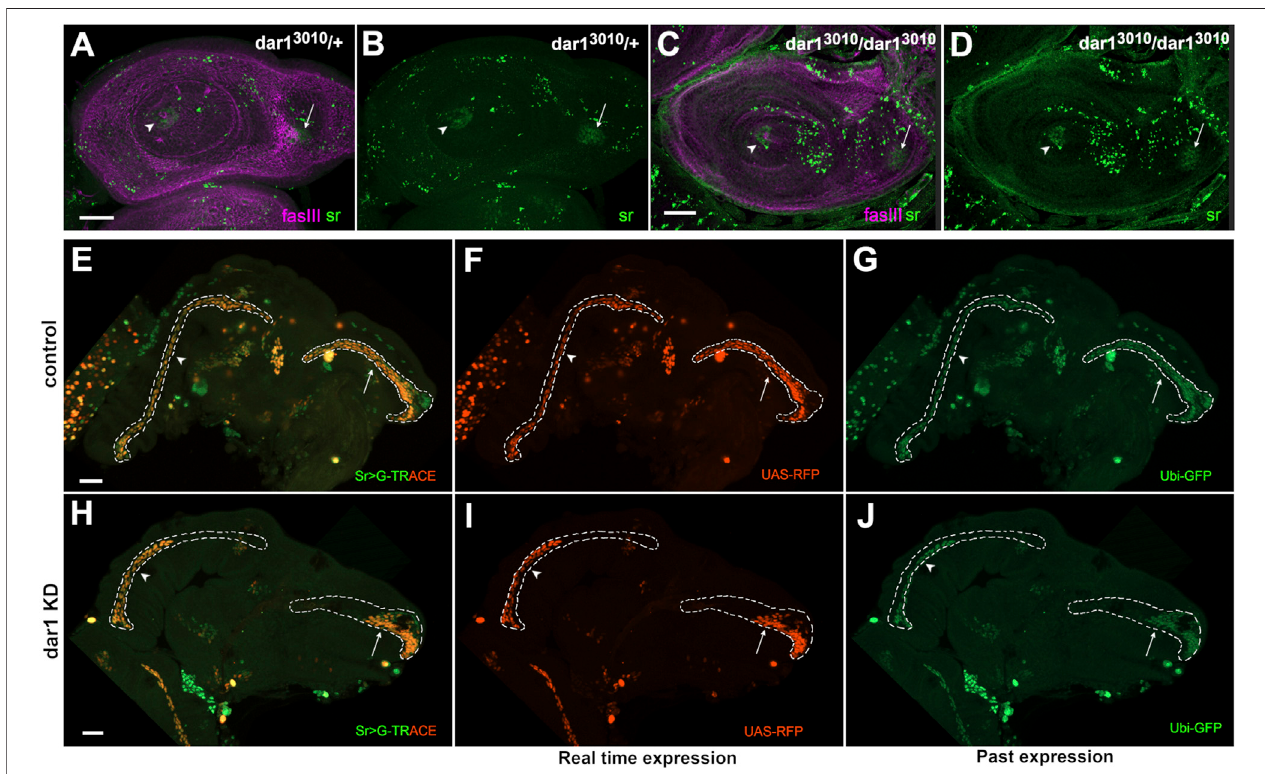
FIGURE 7 | Dar1 is not required to initiate or maintain stripe expression (A – D) Confocal sections of L3 leg discs immunostained with anti-sr (green) and anti-fasIII (magenta) (A – B) In dar1 3010/+ heterozygousleg discs, stripe expression revealstendon cell precursors intarsal segments(arrowhead)andin dorsal femur(arrow) (C – D) In the leg disc of rare dar1 3010/3010 homozygous mutant escapers, stripe expression is still observed in tarsal segments (arrowhead) and dorsal femur (arrow) (total number of analysed discs, control dar1 3010/+ (cid:2) 15, dar1 3010/3010 n (cid:2) 12) (E – J) G-TRACE in sr-gal4,dar1 3010/+ (E – G) and sr-gal4,dar1 3010/+ > UAS-dar1RNAi (H – J) leg discs at 5 h APF. RFP (red) staining shows current sr-gal4 expression (F, I) and GFP (green) reveals past expression (G, J) (E,H) merged G-TRACE expression. Dashedlinesoutlinetarsallt(arrowheads)andtiltindorsalfemur(arrows).Atthisstage,ltandtilthavedeeplyinvaginatedintothedevelopinglegdiscinthecontrol (E – G) , with most of the tendon cells having maintained sr-gal4 expression (red and green staining). By contrast, in dar1 KD leg discs (H – I) , the same tendons appear much shorter withboth current sr-gal4 expression (red) and pastsr-gal4expression (green), indicating that shortening ofthosetendons isnotdue to premature loss ofsr-gal4 expression in “ missing ” cells (extension of dashed lines in dar1 KD pre fi gures the position where GFP positive cells should have been detected if the apparent tendon shortening was due to a premature loss of sr-gal4 expression). Scale bar 30 μ m.